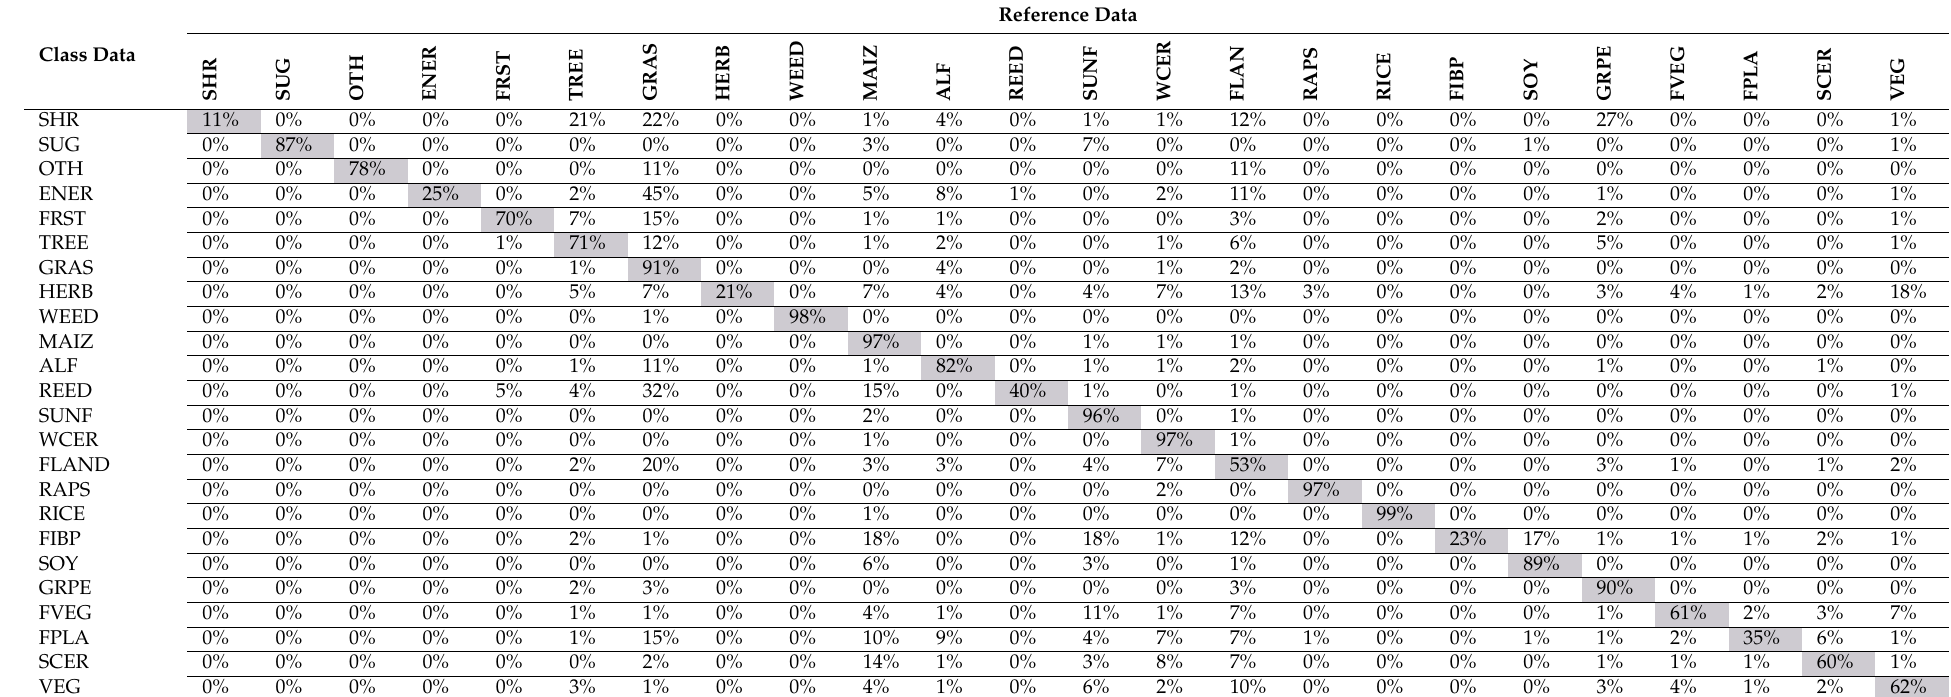
Table 3. Confusion matrix of crop categorization with random